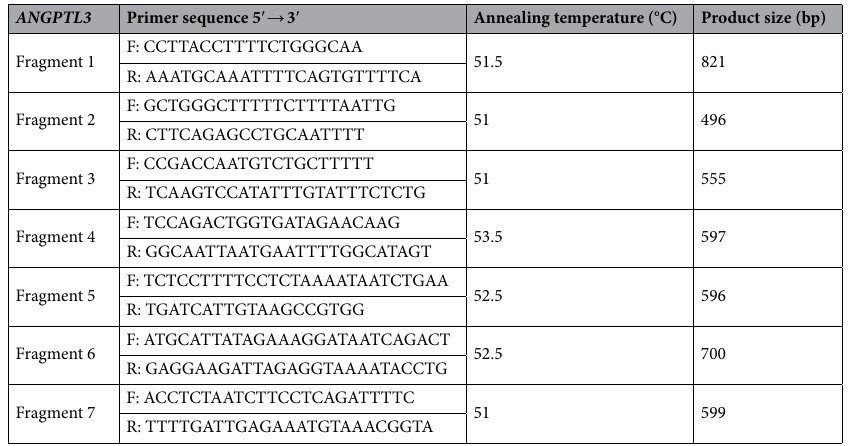
Table 1. Primers and conditions used for ANGPTL3 amplification and sequencing. Each amplified fragment comprises the corresponding exon and its 5 ′ and 3 ′ flanking sequences, including intron–exon boundaries. F forward, R